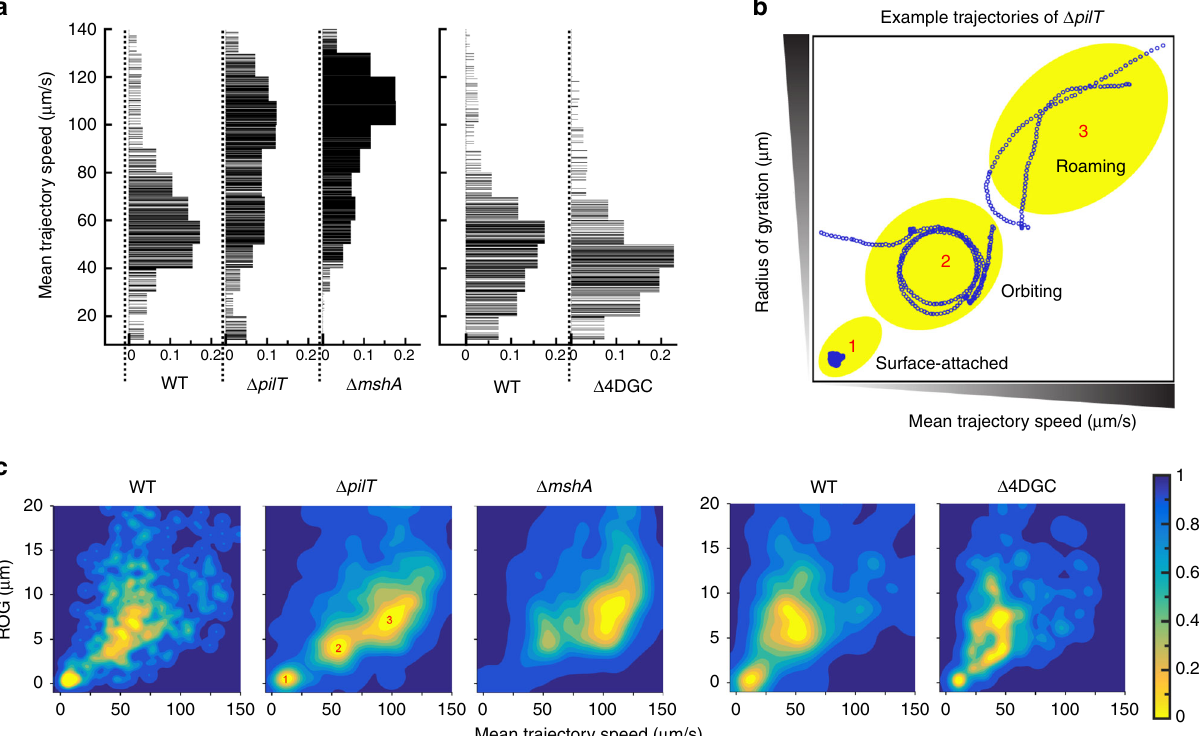
Fig. 5 PilT-mediated MSHA retraction impacts near-surface motility patterns. a Comparison between the mean trajectory speed (MTS) for WT, Δ pilT and Δ mshA . A similar comparison between WT and Δ 4DGC is made in a separate experiment, to minimize errors from variations of external conditions. Each horizontal line in the plot represents one trajectory. The widths of the lines represent the distribution probabilities with a bin width of 10 µ m per second. b Representative trajectories (marked by open blue circles) from these distinctive loci (represented by underlaid yellow ovals) are shown. Locus 1 is represented with a surface-attached cells; locus 2 with an orbiting cell, and locus 3 with a roaming cell. c Contour maps showing the radius of gyration (ROG) vs mean trajectory speed (MTS) for all trajectories in c : WT, Δ pilT and Δ mshA in the fi rst comparison, and WT and Δ 4DGC in the second comparison. The contour plot for all measured trajectories are peaked at several loci: These loci can be seen most clearly in Δ pilT , numbered 1, 2, and 3, corresponding to the trajectories highlighted in